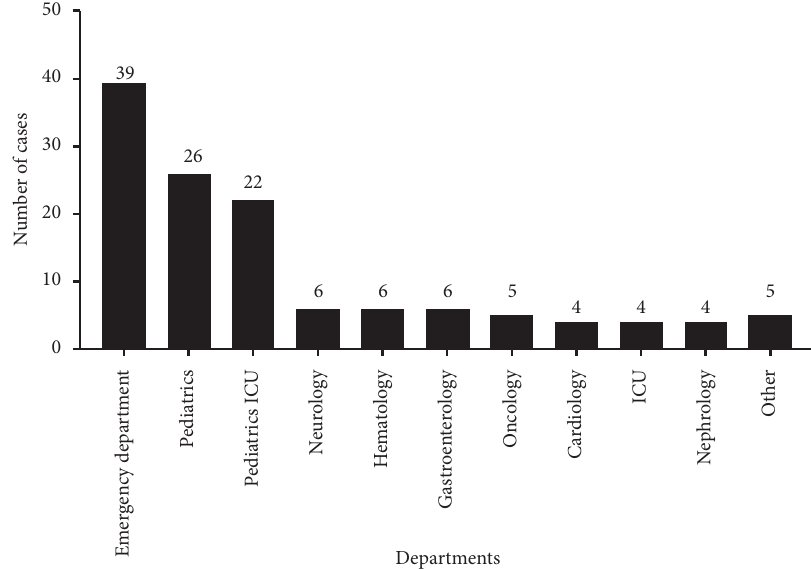
Figure 2: Departments distribution of patients with IPD in Ningxia Hui Autonomous Region, China,